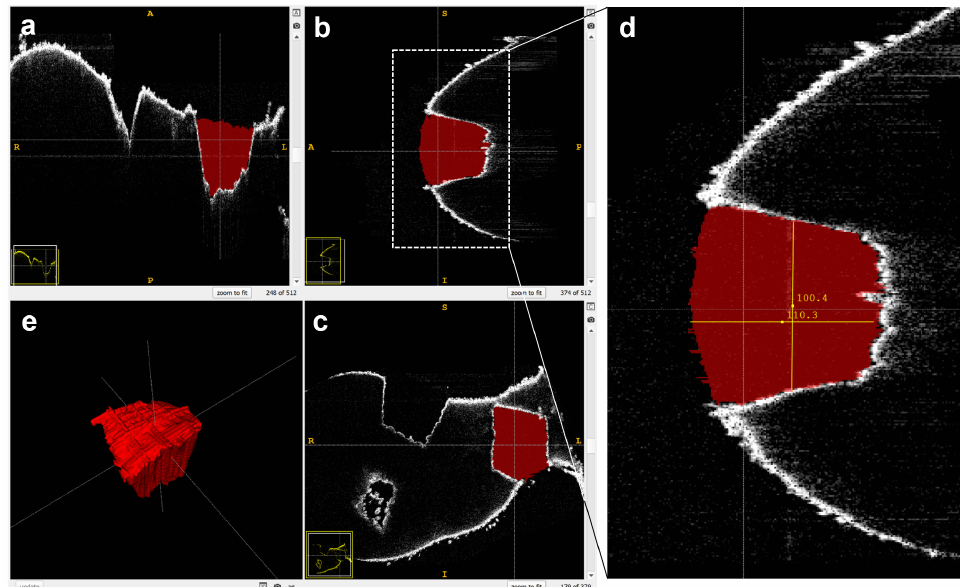
Figure 2. Example of 3D segmentation of an ablation site with the open-source software ITK Snap 3.8.0 [28]. ( a – c ) Slice views of the three dimensions; ( d ) Determination of the mean volume dimensions in pixels with the integrated measuring tool; ( e ) 3D rendering of the segmented volume. Table 1. Ablation volumes and dimensions of the three ablation sites of a formalin-fixed murine spleen, determined with optical coherence tomography (OCT) for reference. Volume was determined based on the voxel count and the dimensions (mean width and depth) based on random distance measurements of the segmentation.